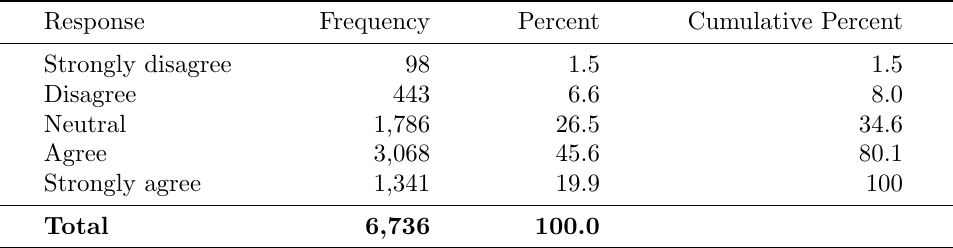
Table 1: Responses to the statement “I feel a sense of pride in the way [my city] looks and feels”. Twelve New Zealand cities,